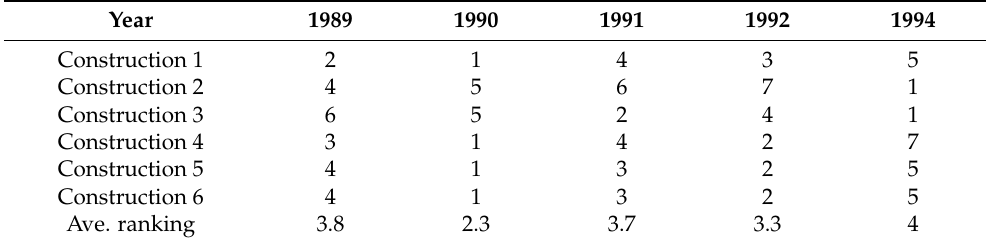
Table 3. Rankings related to the worst year